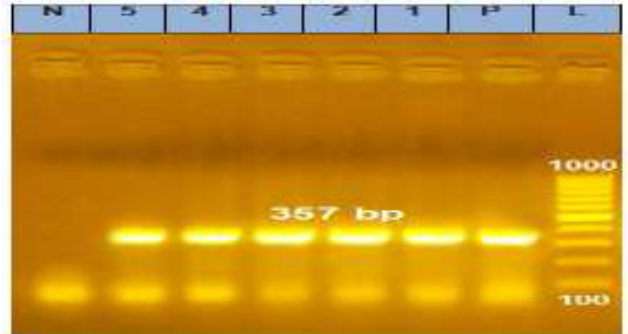
Fig. 1: PCR amplification of the 357 bp fragment of Aspergillus 18S rRNA gene from 5 A. flavus isolates (1-5), P. (control positive), N. (control negative) .